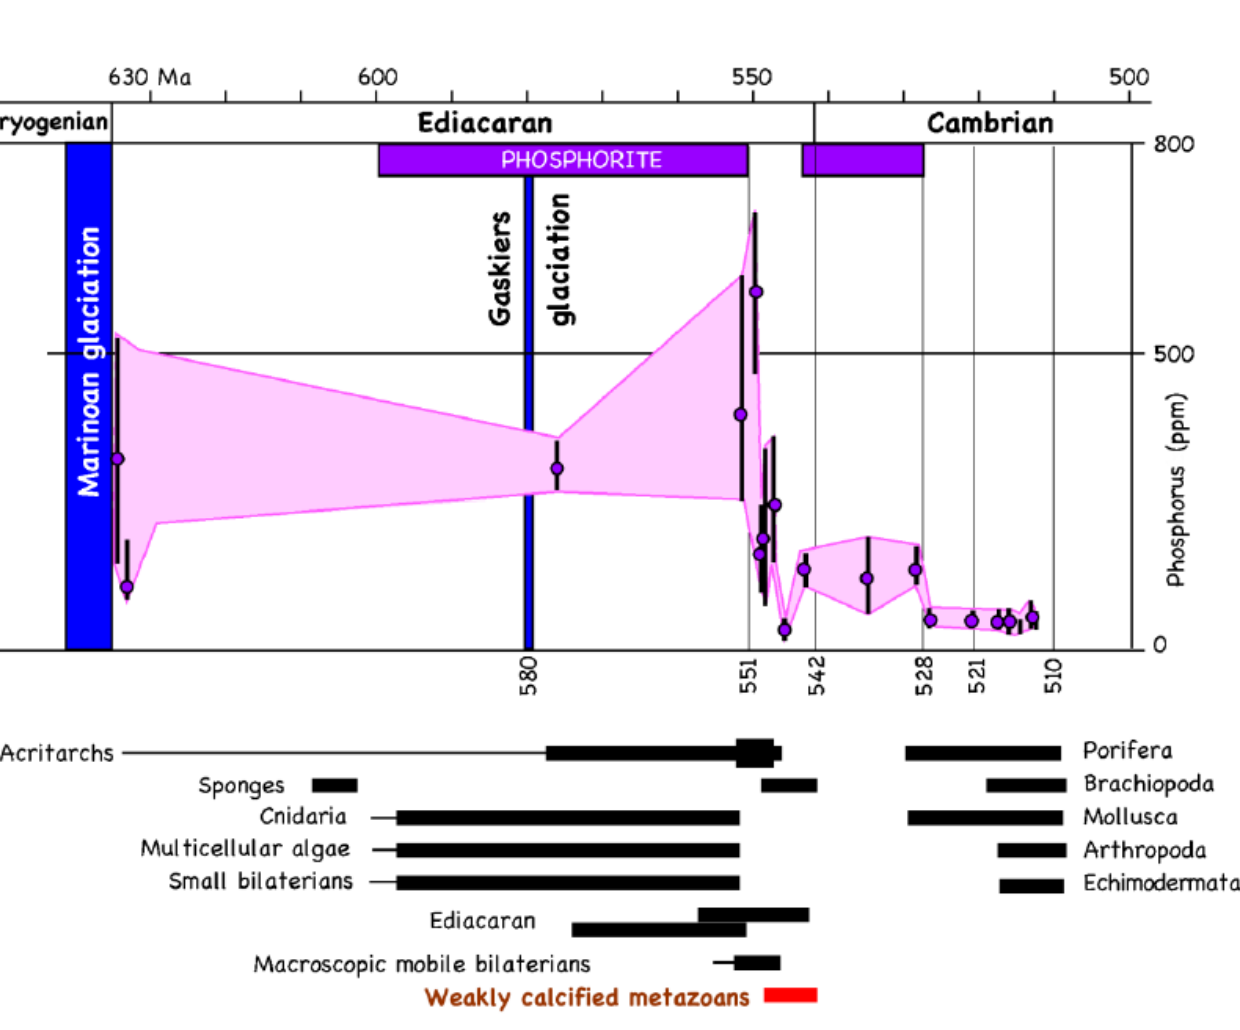
Figure 5. Evolution of Phosphorous (P) concentration through the late Neoproterozoic and Cambrian and its relationship with the emergence of major groups of organisms. Notice that the first weakly calcified metazoans (red bar) appeared during a minimum of P at the end of the Ediacaran. Modern lineages of metazoans with hard skeletons appeared by mid-Cambrian during another minimum in P concentration. (This figure is an original interpretation by L. Pomar based on numerous sources).